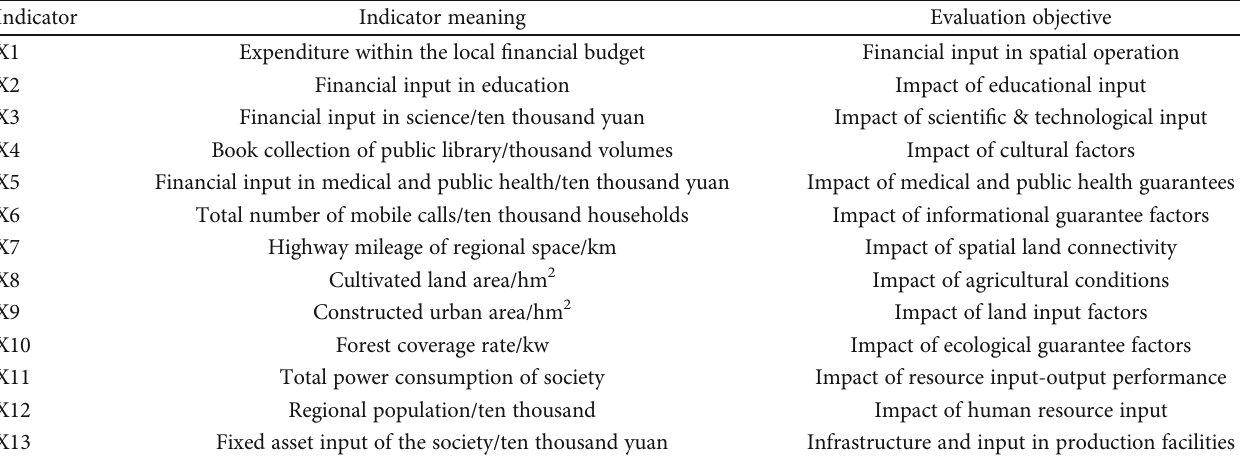
Table 1: Indicators of the urban-rural spatial e ffi ciency input